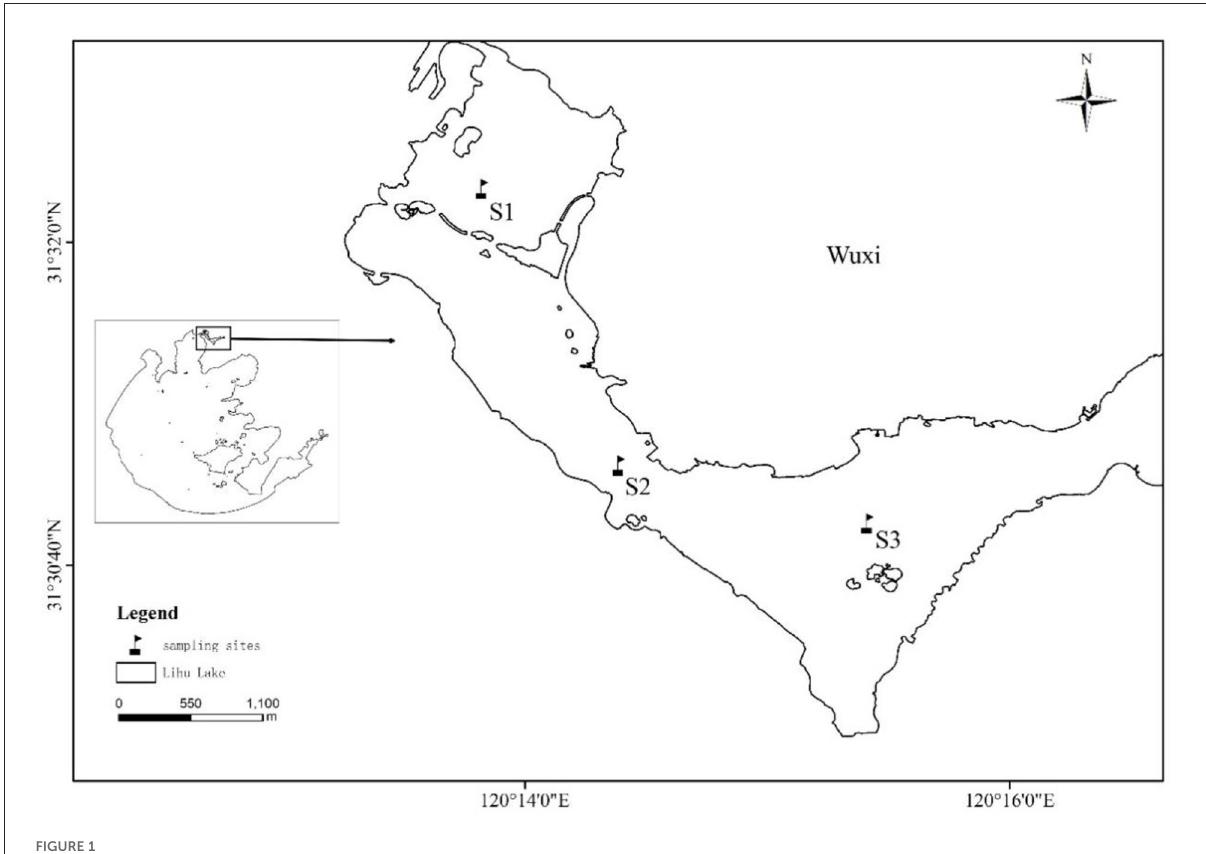
FIGURE1 Sampling sites in Lihu